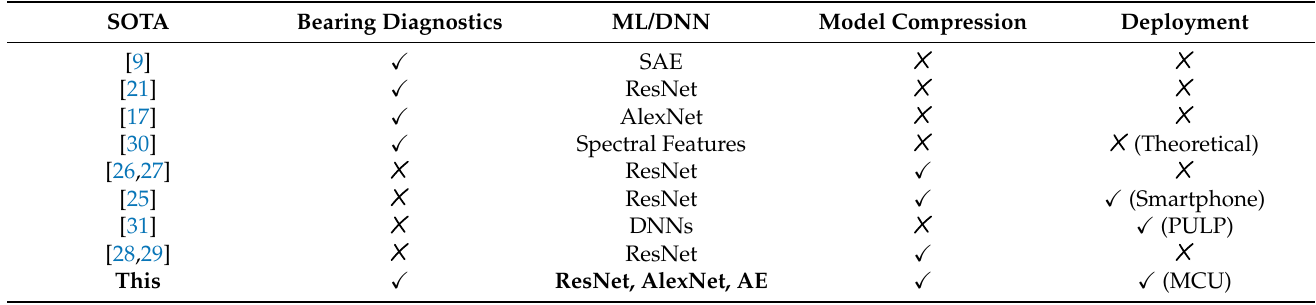
Table 1. Comparison among the State Of The Art works and the current